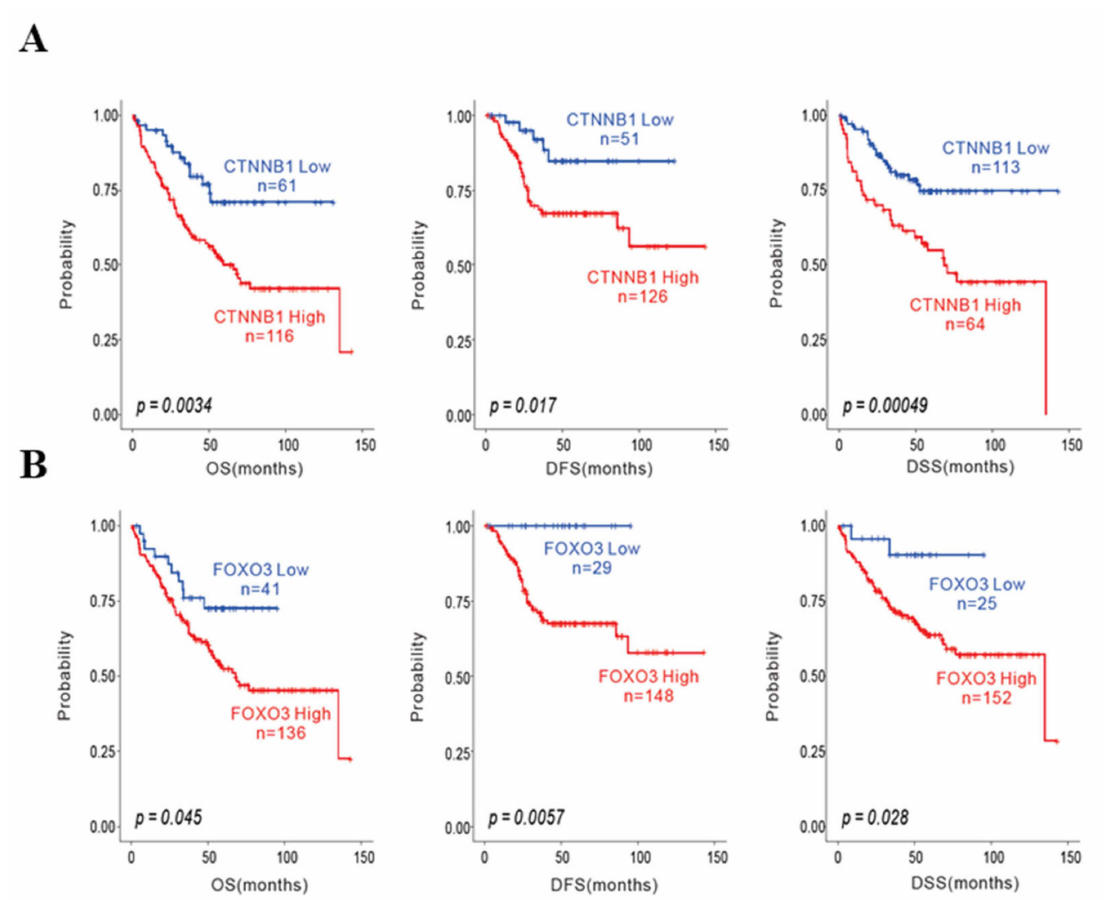
Figure 1. Prognostic values (survival analysis) of the gene expressions in CRC patients, based on the GSE dataset (GSE17536). The effects of the high or low expression of ( A ) CTNNB1 and ( B ) FOXO3a with overall survival (OS), disease-free survival (DFSS), and disease-specific survival (DSS) in CRC patients. OS, overall survival; DFS, disease-free survival; DSS, disease-specific